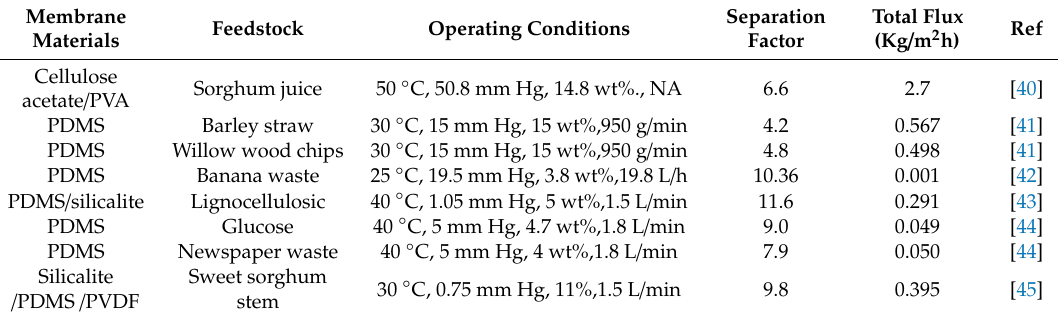
Table 1. Summary of studies about the e ff ect of di ff erent operating conditions on pervaporation separation membrane using di ff erent membrane materials.